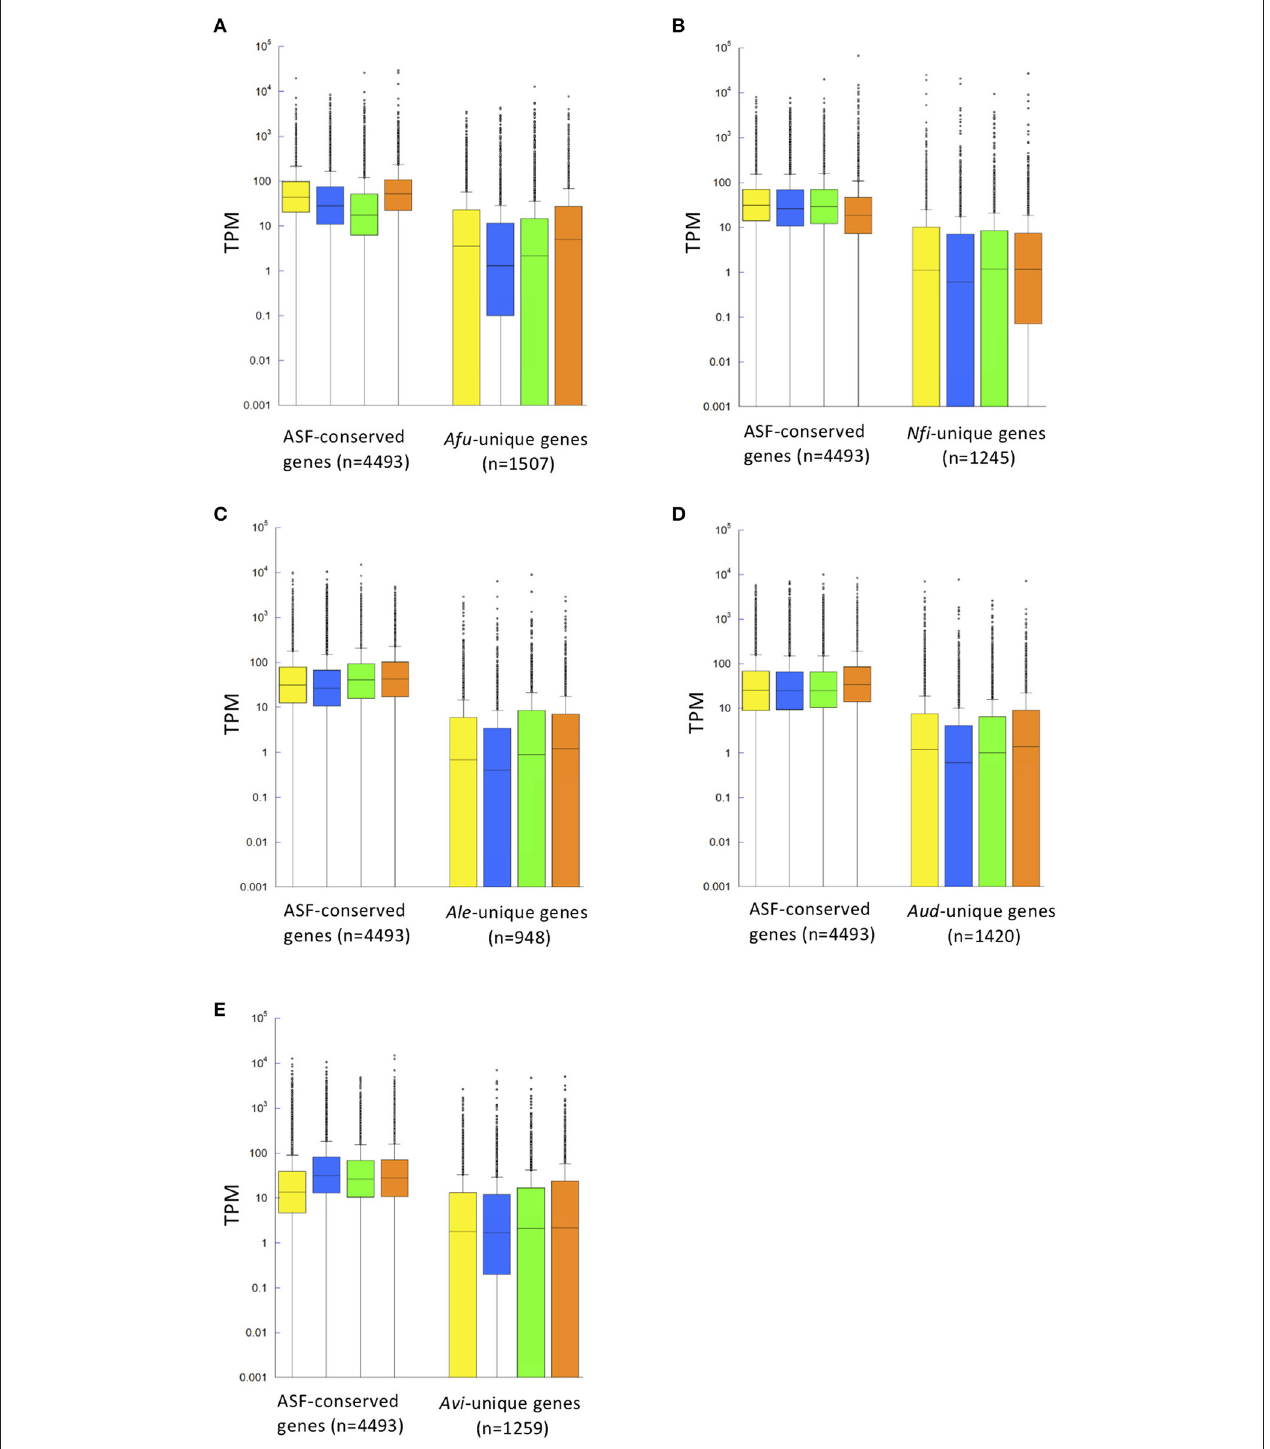
FIGURE 3 | Distribution of gene expression levels shown in a box plot. Gene expression patterns of ASF-conserved genes as the core genome ( n = 4,493) and species-unique genes are shown for A. fumigatus (A) , N. fischeri (B) , A. lentulus (C) , A. udagawae (D) , and A. viridinutans (E) in four different conditions [potato dextrose broth (PDB), Czapek-Dox medium (CD), Sabouraud broth (SB), and potato dextrose agar (PDA)], indicated by yellow, blue, green, and orange boxes, respectively. Gene expression levels are described in Transcripts Per Kilobase Millions (TPM) obtained in RNA-sequencing analysis. The box plot graph is drawn using PlotsOfData (https://huygens.science.uva.nl/PlotsOfData/) (Postma and Goedhart, 2019).